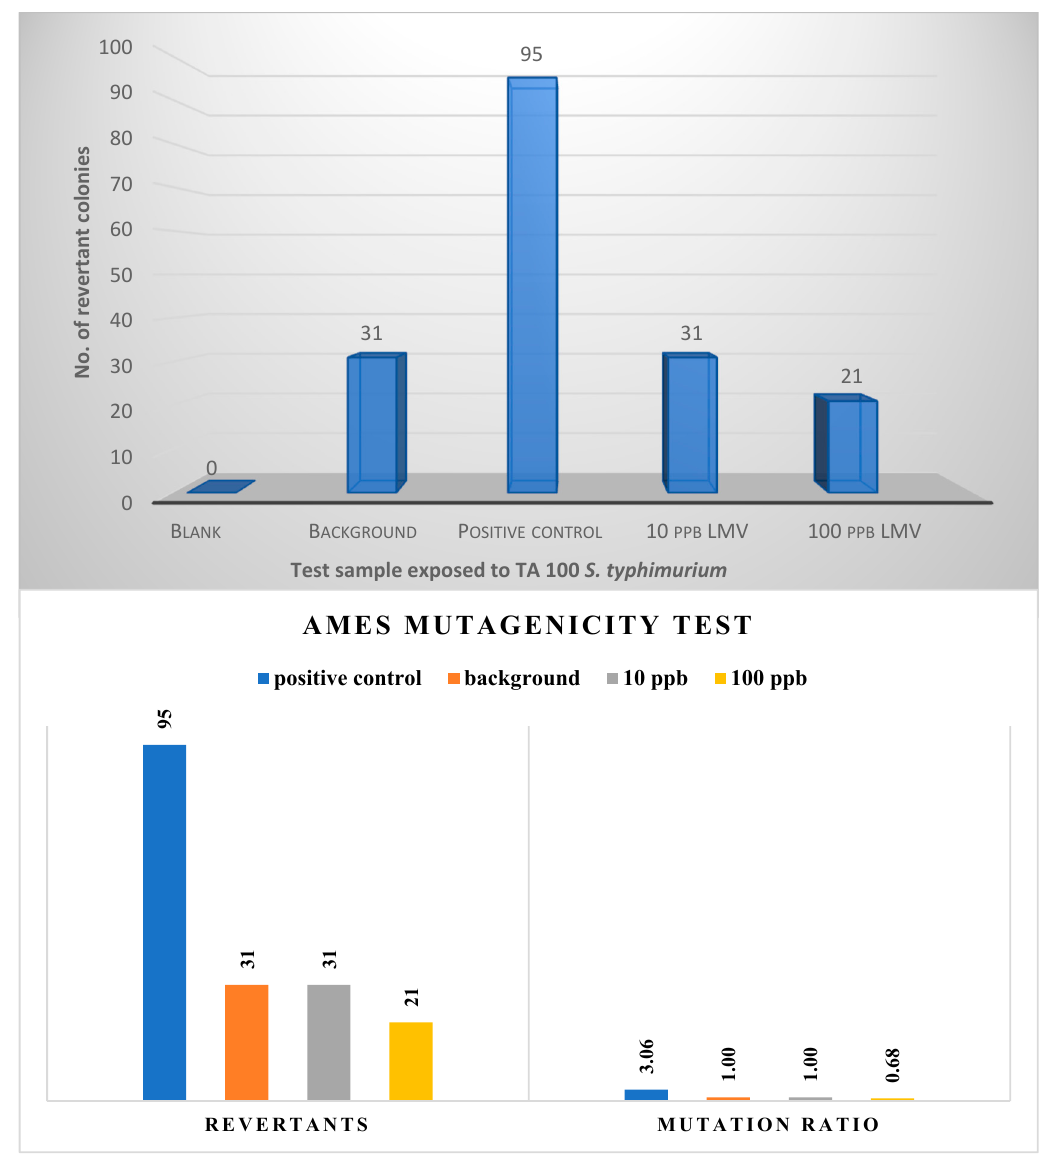
Figure 3. Result of mutation rate obtained from Ames test using EPBI kit.